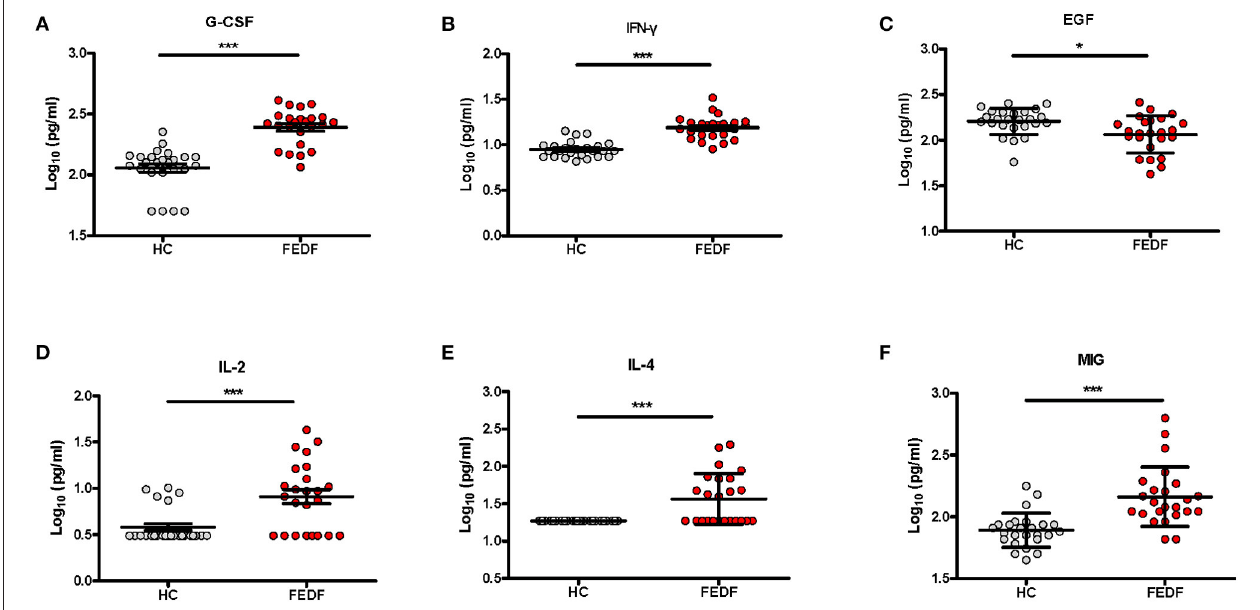
FIGURE 1 | Serum levels of the G-CSF (A) , IFN- γ (B) , EGF (C) , IL-2 (D) , IL-4 (E) , and MIG (F) levels in FEDF patients with SCZ and HC subjects. SCZ, schizophrenia; FEDF, first-episode, drug-free; HC, healthy control; IFN, interferon; G-CSF, granulocyte colony-stimulating factors; MIG, monokine induced by interferon- γ ; IL, interleukin; EGF, epidermal growth factor. * P < 0.05, *** P <